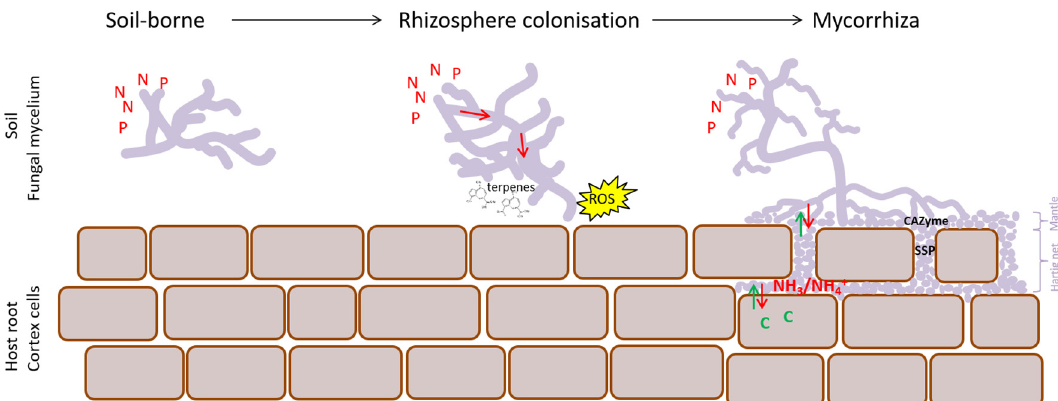
Figure 6. Dynamics of EcM development. Transition from soil-borne mycelium towards functional symbiosis requires a two-step transcriptional reprogramming. Initial contact with a plant host, when entering the rhizosphere, marks the first step and results in priming of the mycelium with roles suggested for ROS signaling and terpenes. The second step corresponds to functional differentiation between ExM and EcM with differential expression of CAZymes, SSPs, nitrogen (amino acid and ammonium) and sugar transporters. At this point, both fungal mantle and Hartig net are well-developed and visible. ROS = reactive oxygen species; SSP = small secreted protein; aa = amino